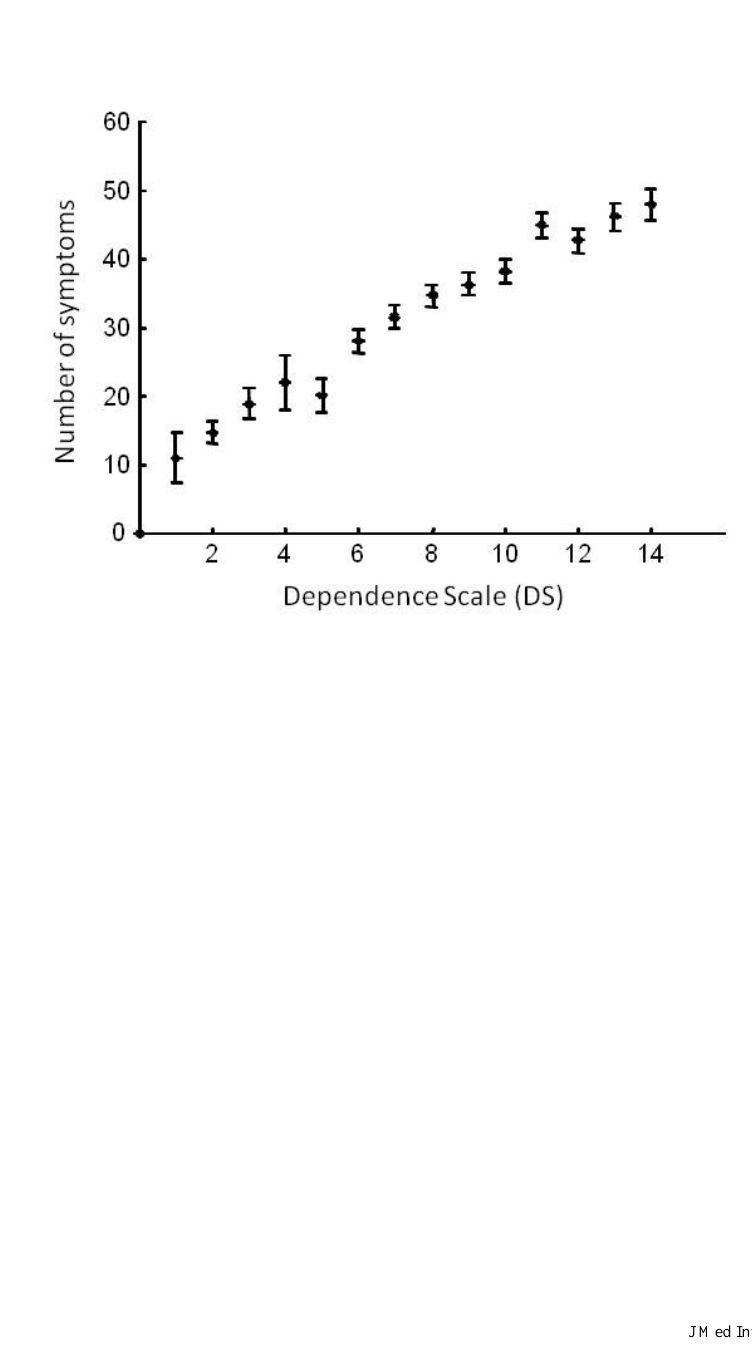
Figure 1. Mean number of dementia symptoms as a function of the Dependence Scale score. Circles show the means and bars show the standard